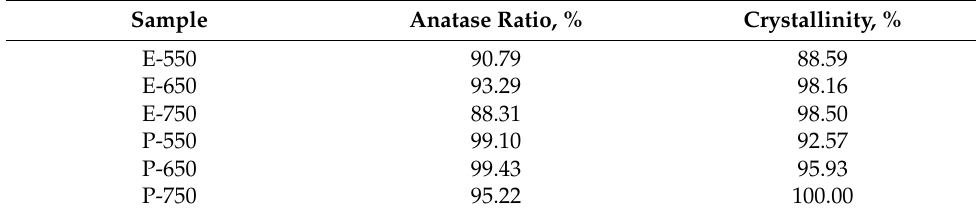
Table 2. Particle sizes calculated from the XRD